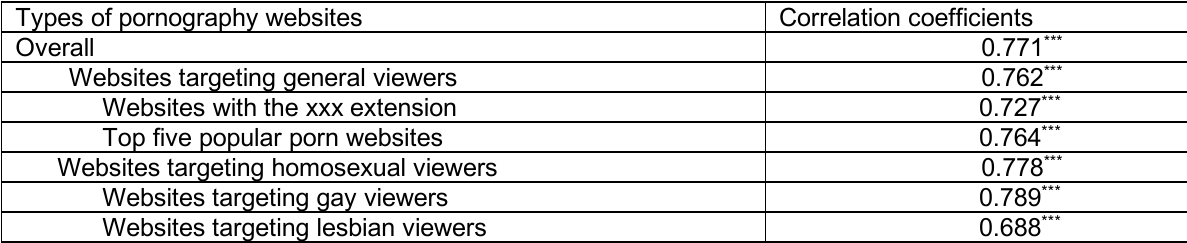
Table 4: Correlation coefficients between pageview and visit duration